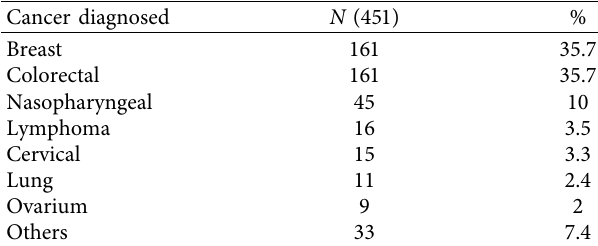
Table 2: Patients’ characteristics. Table 3: Patients’ cancer